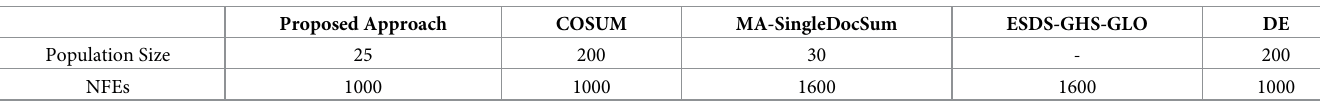
Table 7. Population size and number of fitness evaluation (NFE) used by different optimization approaches. ‘-’ indicates value not mentioned in the reference paper. Proposed